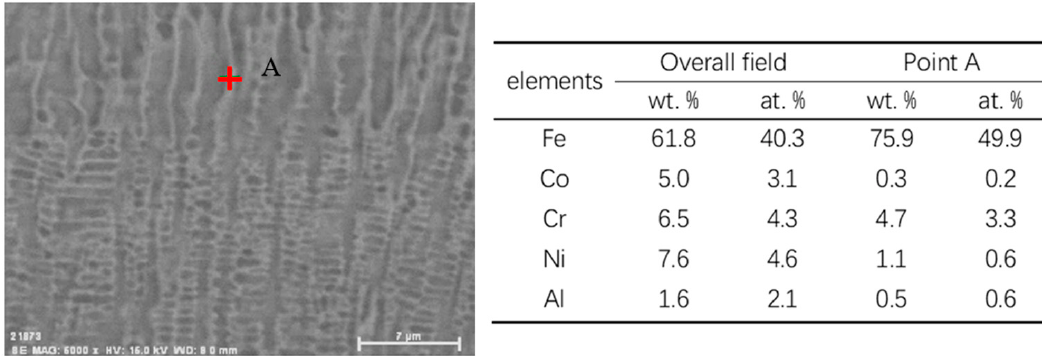
Figure 3. EDS analysis of the MEA coating, the overall composition, and the bright phase between dendrites (point A).